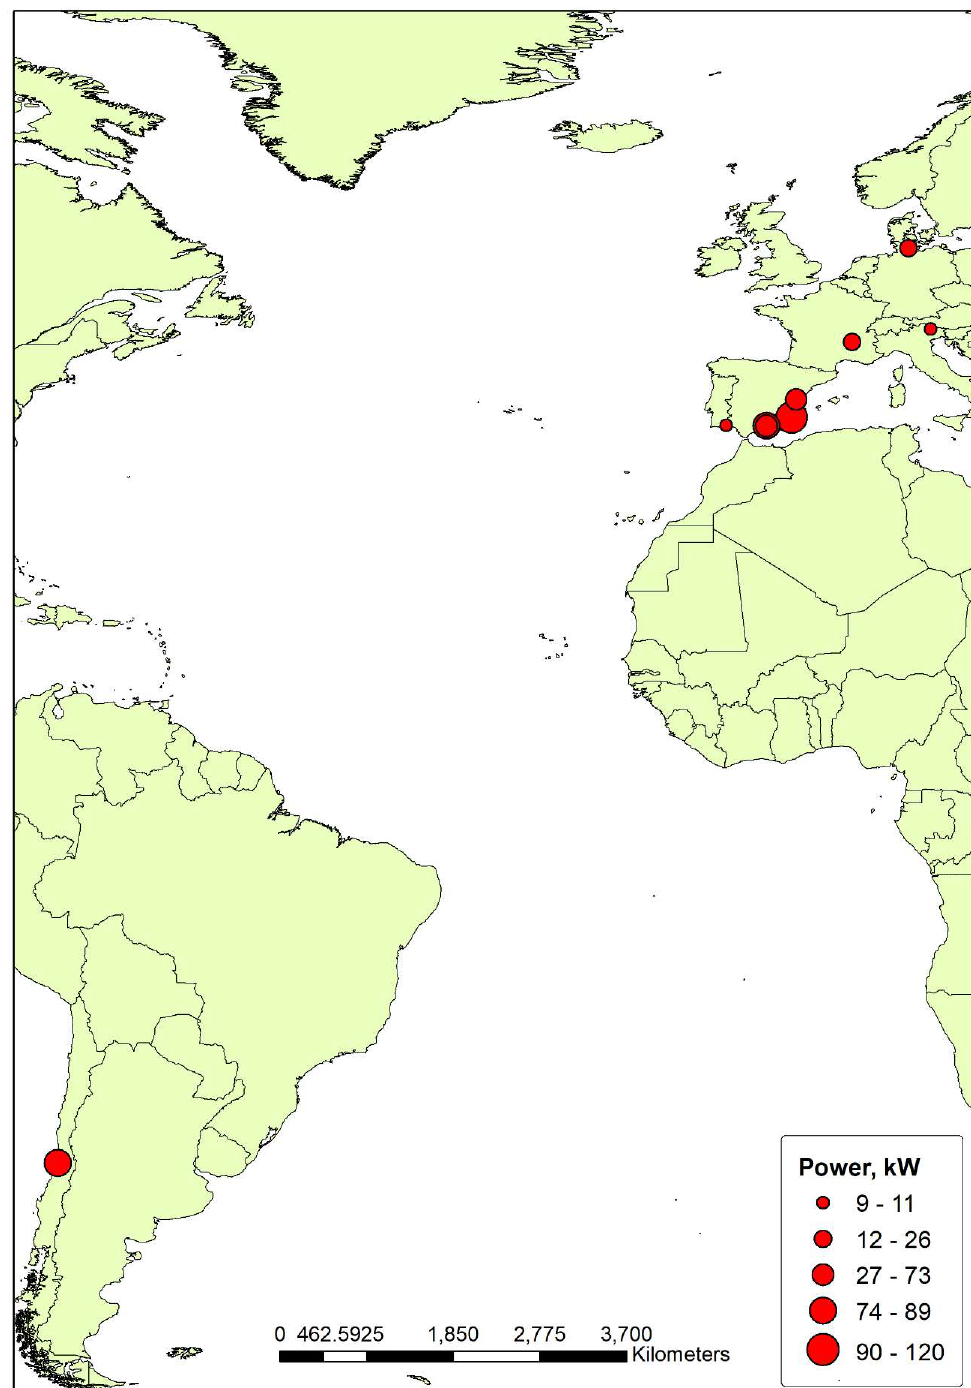
Figure 3. Location of the PAT plants used to estimate the total PAT cost.